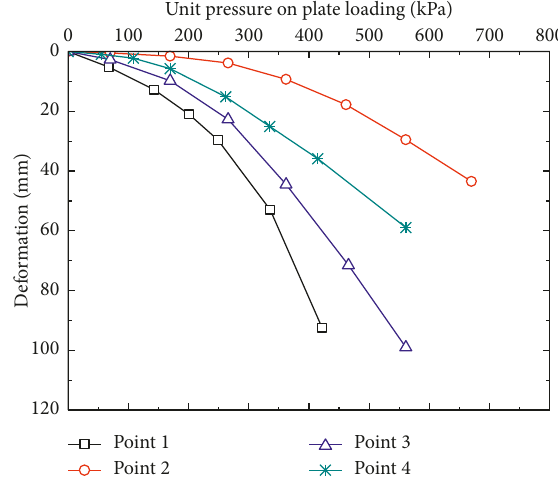
Figure 6: Stress-deformation curve of plate loading